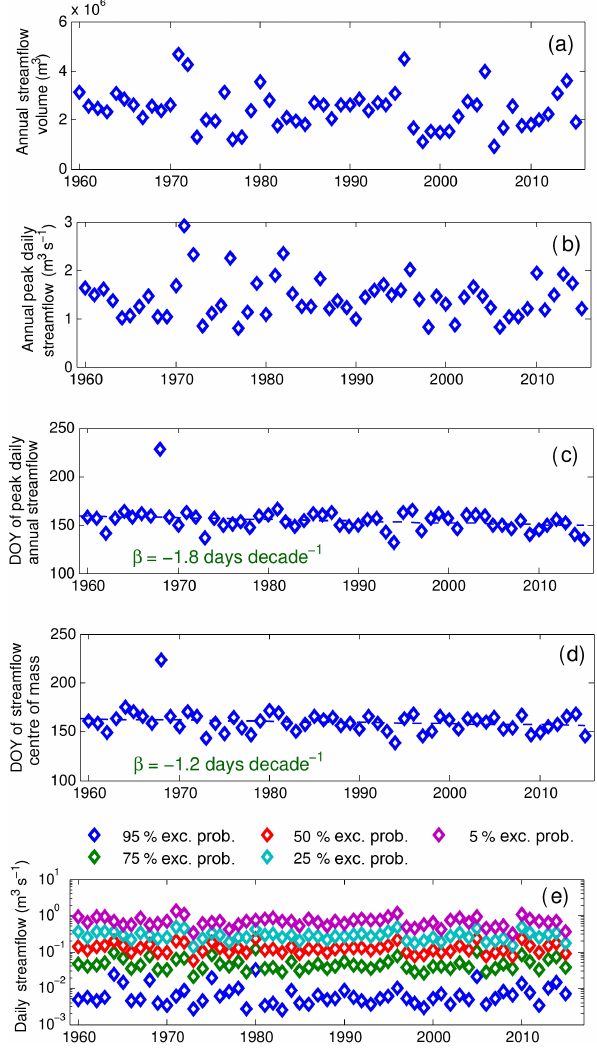
Figure 9. (a) Annual streamflow volume. (b) Annual peak daily streamflow. (c) Day of the year (DOY) of peak daily stream- flow. (d) DOY of streamflow volume discharge centre of